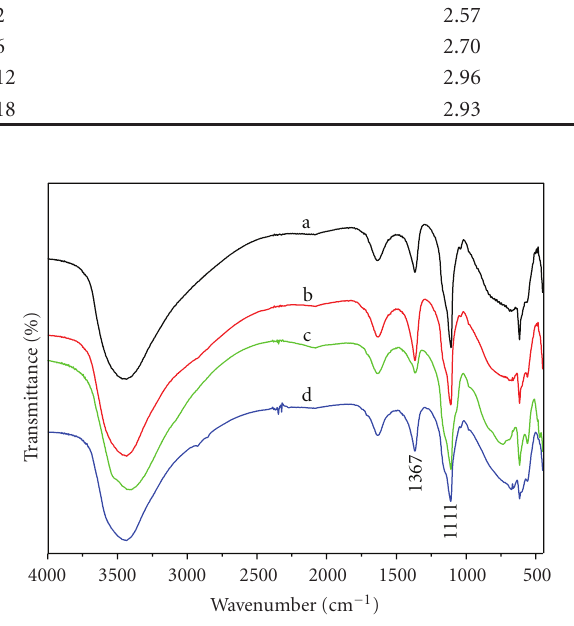
Figure 4: IR spectra of Ni/Al LDHs prepared with di ff erent reaction times a: 2 h; b: 6h; c: 12h; d: 18 h.